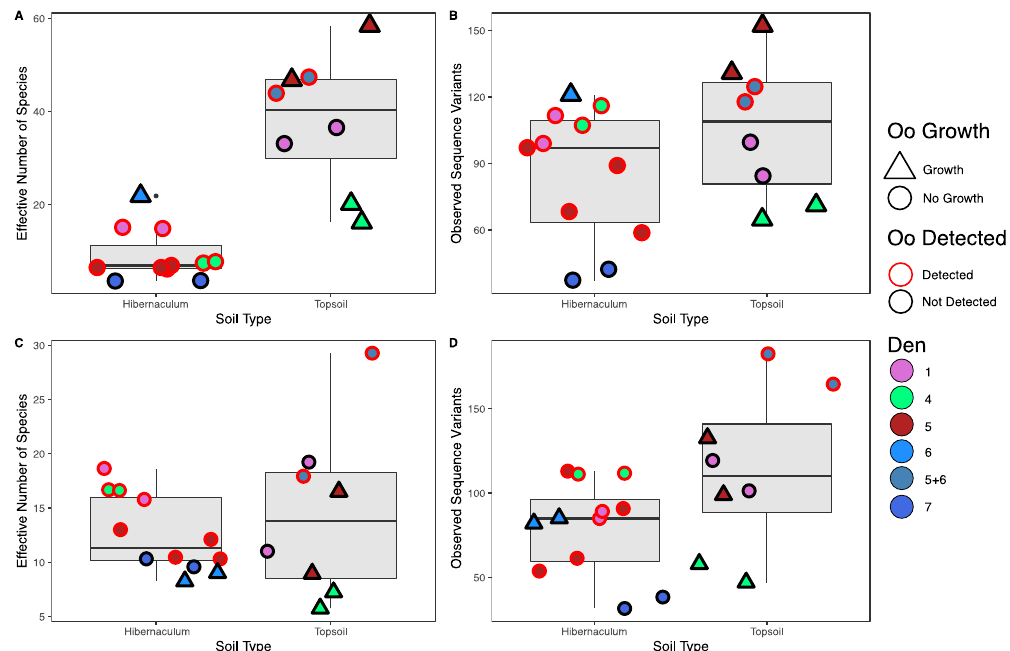
Figure 2. Alpha diversity plots of ( A ) bacterial communities of experimental soils based on effective number of species (ENS) scores; ( B ) bacterial communities of soils based on raw number of observed SVs; ( C ) fungal communities of experimental soils based on ENS scores; and ( D ) fungal communities of soils based on raw number of observed SVs. Each den is represented by a distinct color, and the left box plot of each plot displays soils collected from within hibernacula and the right displays associated topsoil samples. Soils in which Oo was detected prior to experimental inoculation are outlined in red, while those with no Oo detected are outlined in black. Soils in which Oo grew during experimental microcosm assays are represented by triangular points, while those in which it did not are represented by circular points. The diversity and richness of bacterial communities were lower in hibernaculum samples compared to topsoil samples. Bacterial diversity and richness were also significantly lower in soils which permitted Oo growth. Fungal diversity and richness were lower in hibernaculum samples than topsoil samples. Fungal diversity and richness were also higher in those soils in which environmental Oo was detected.